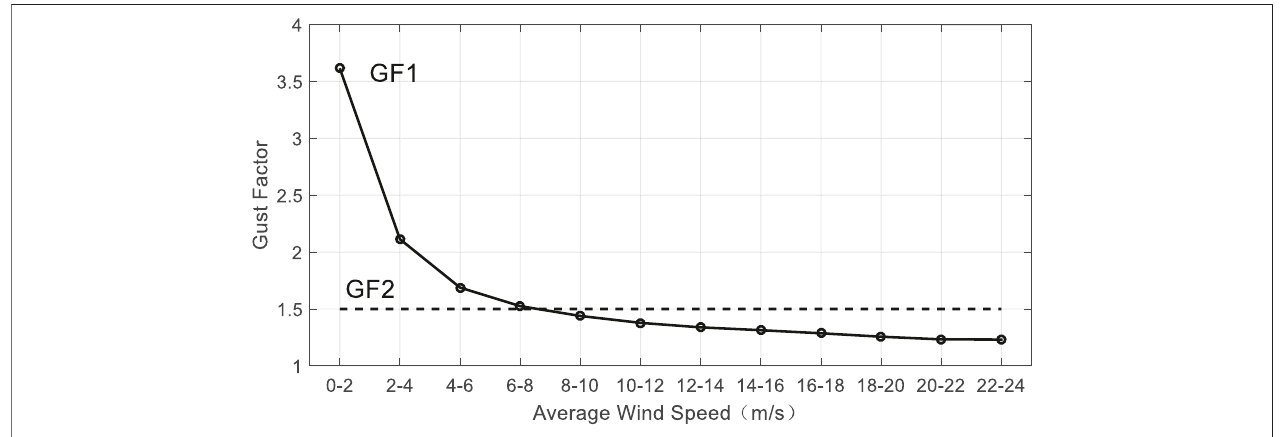
FIGURE 4 | The gust factors as a function of average wind speed (GF1) and overall sample (GF2) calculated from the data from 2017 to 2019.